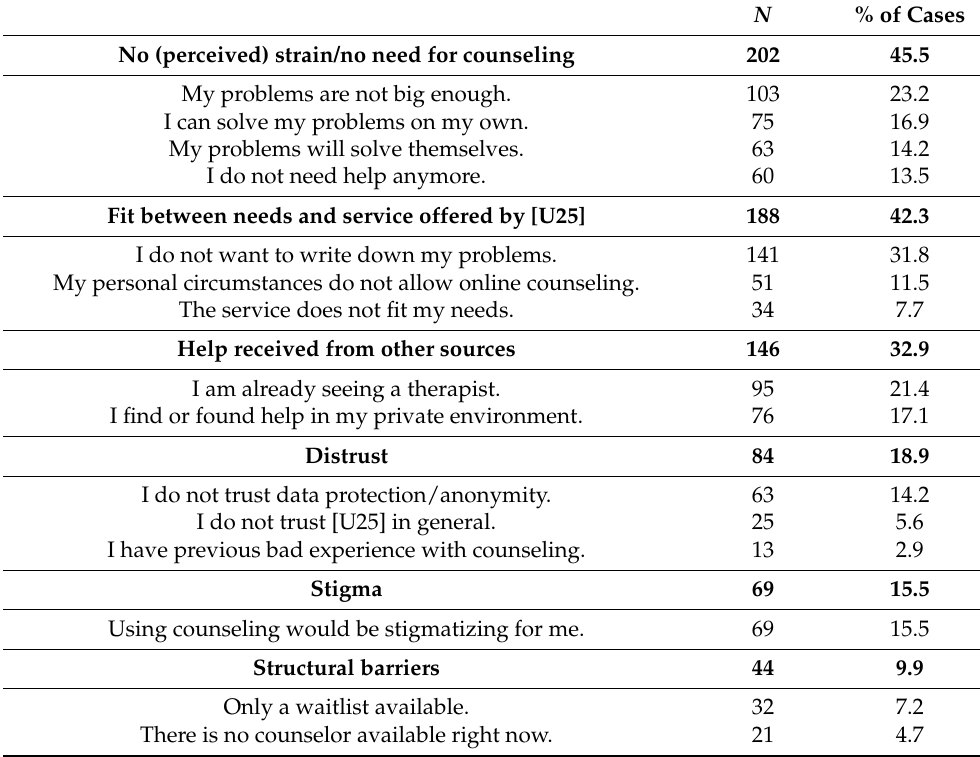
Table 3. Barriers for utilization of [U25]; only refusers ( n = 444) (multiple